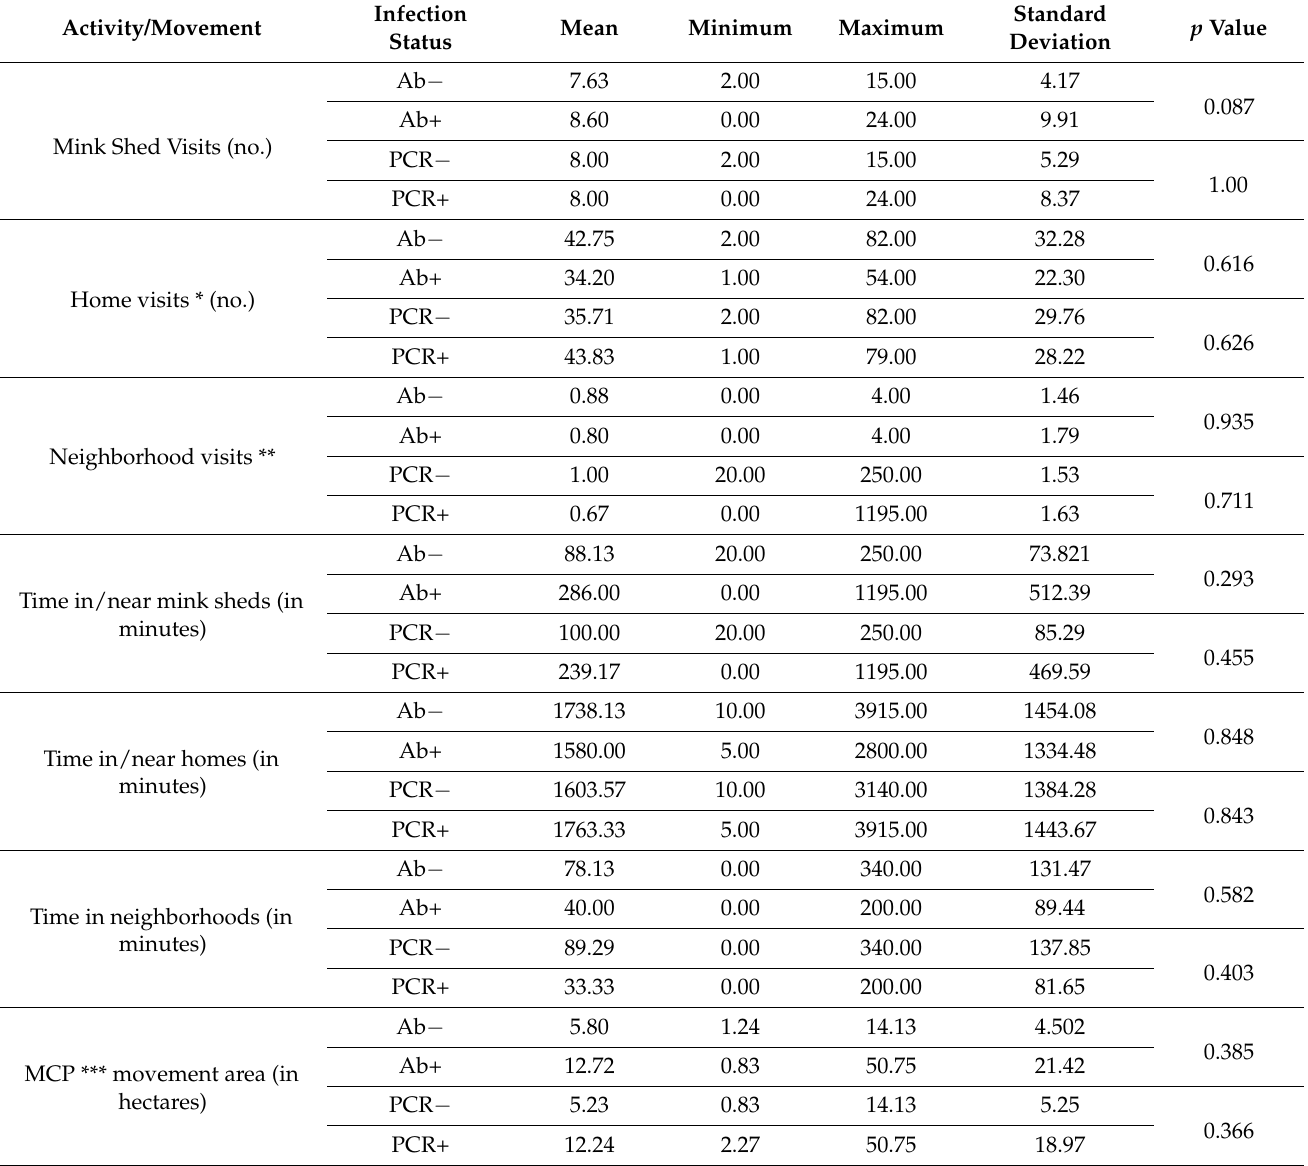
Table 3. Comparison of mean activity and movement with respect to SARS-CoV-2 infection status (measured by SARS-CoV-2 PCR and antibody tests) of cats (n = 13) near SARS-CoV-2-infected mink